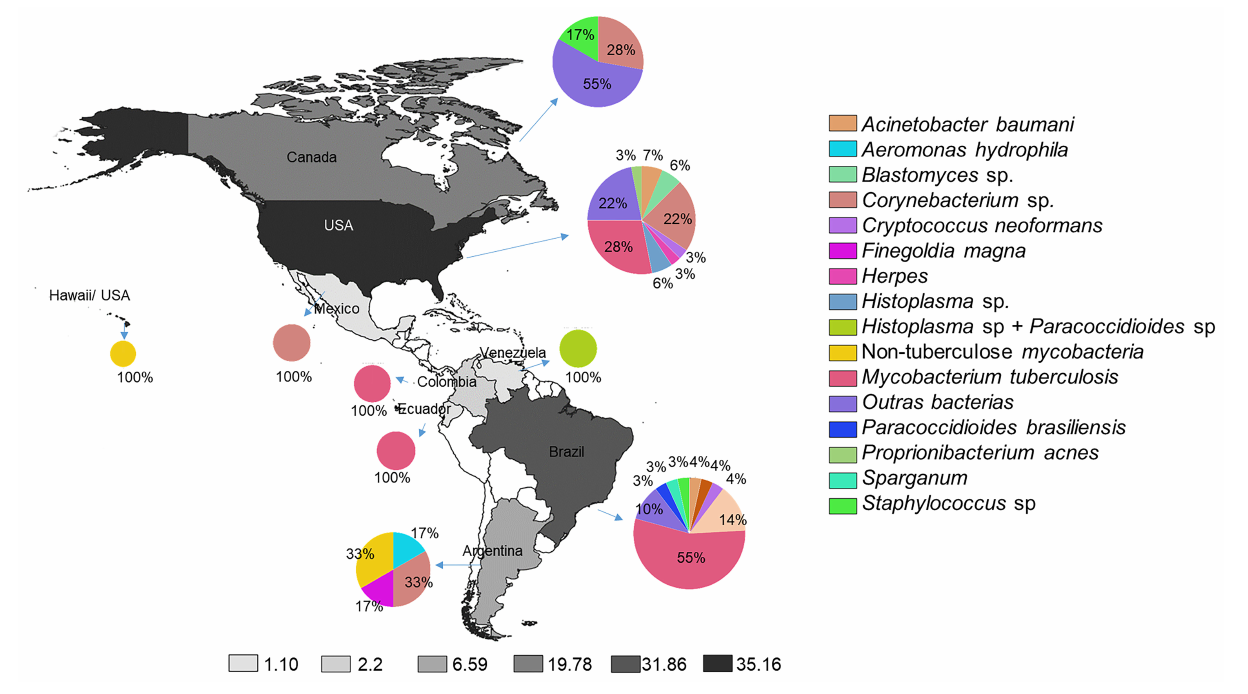
FIGURE 2 | The prevalence of non-lactational infectious mastitis in American countries and the register of etiological infection agents.